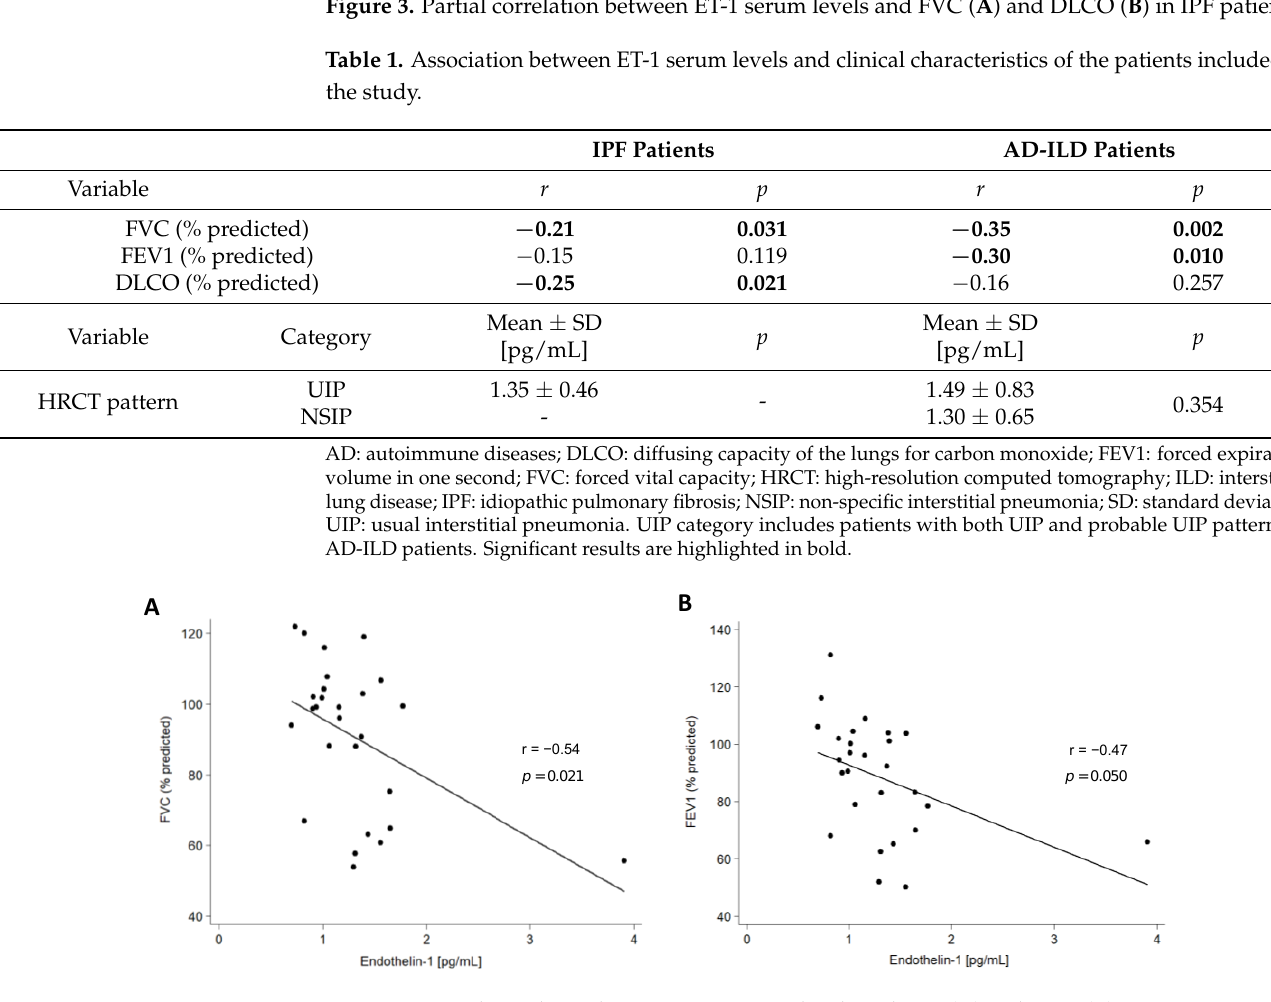
Figure 4. Partial correlation between ET-1 serum levels and FVC ( A ) and FEV1 ( B ) in RA-ILD patients. No significant differences were found between the ET-1 levels and other clinical characteristics of patients with IPF, the whole cohort of AD-ILD patients or each type of AD-ILD patient (Tables 1 and